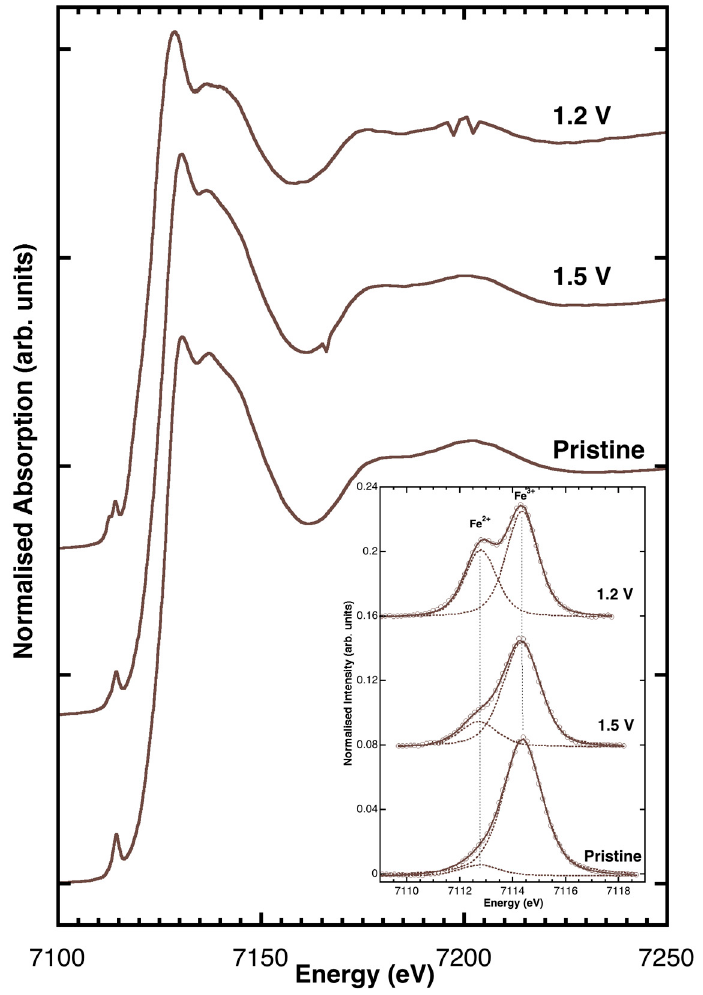
Figure 5. Fe K-edge XANES (X-ray absorption near edge structure) spectra measured ex situ for carbon-coated Zn 0.9 Fe 0.1 O anodes before electrochemical testing (pristine) and discharged to 1.5 and 1.2 V vs. Li + /Li.